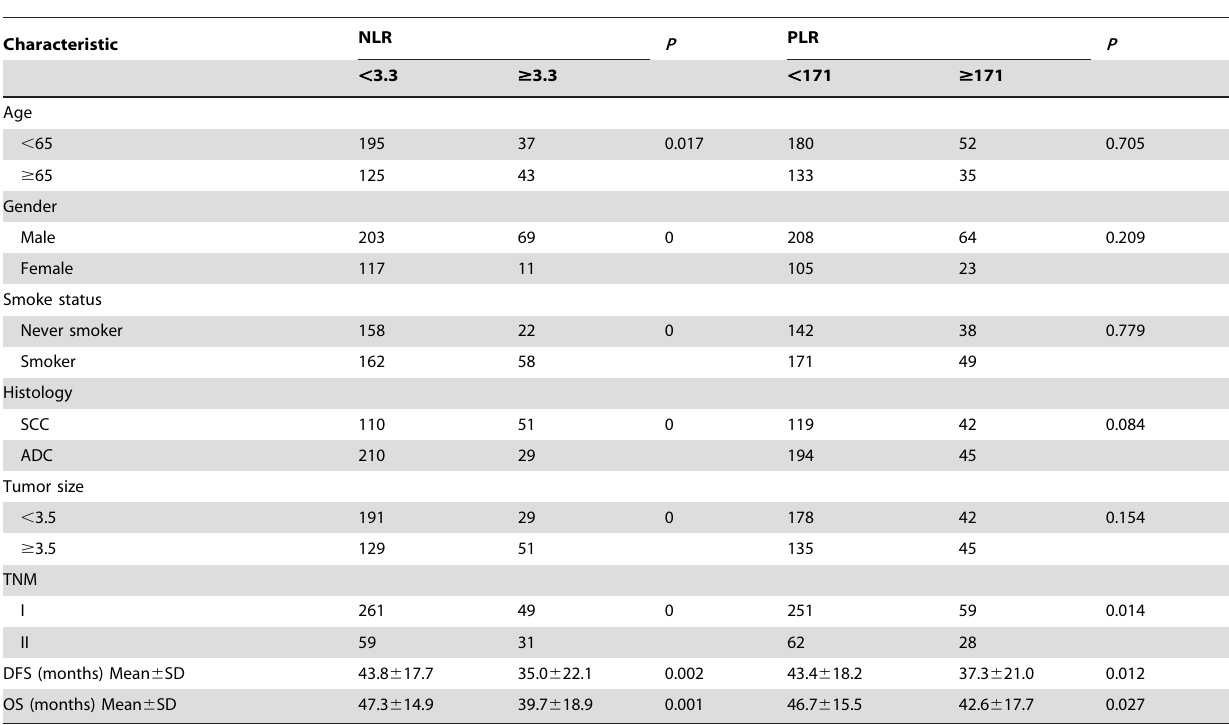
Table 2. Distribution of clinical characteristics stratified by pretreatment NLR or PLR.